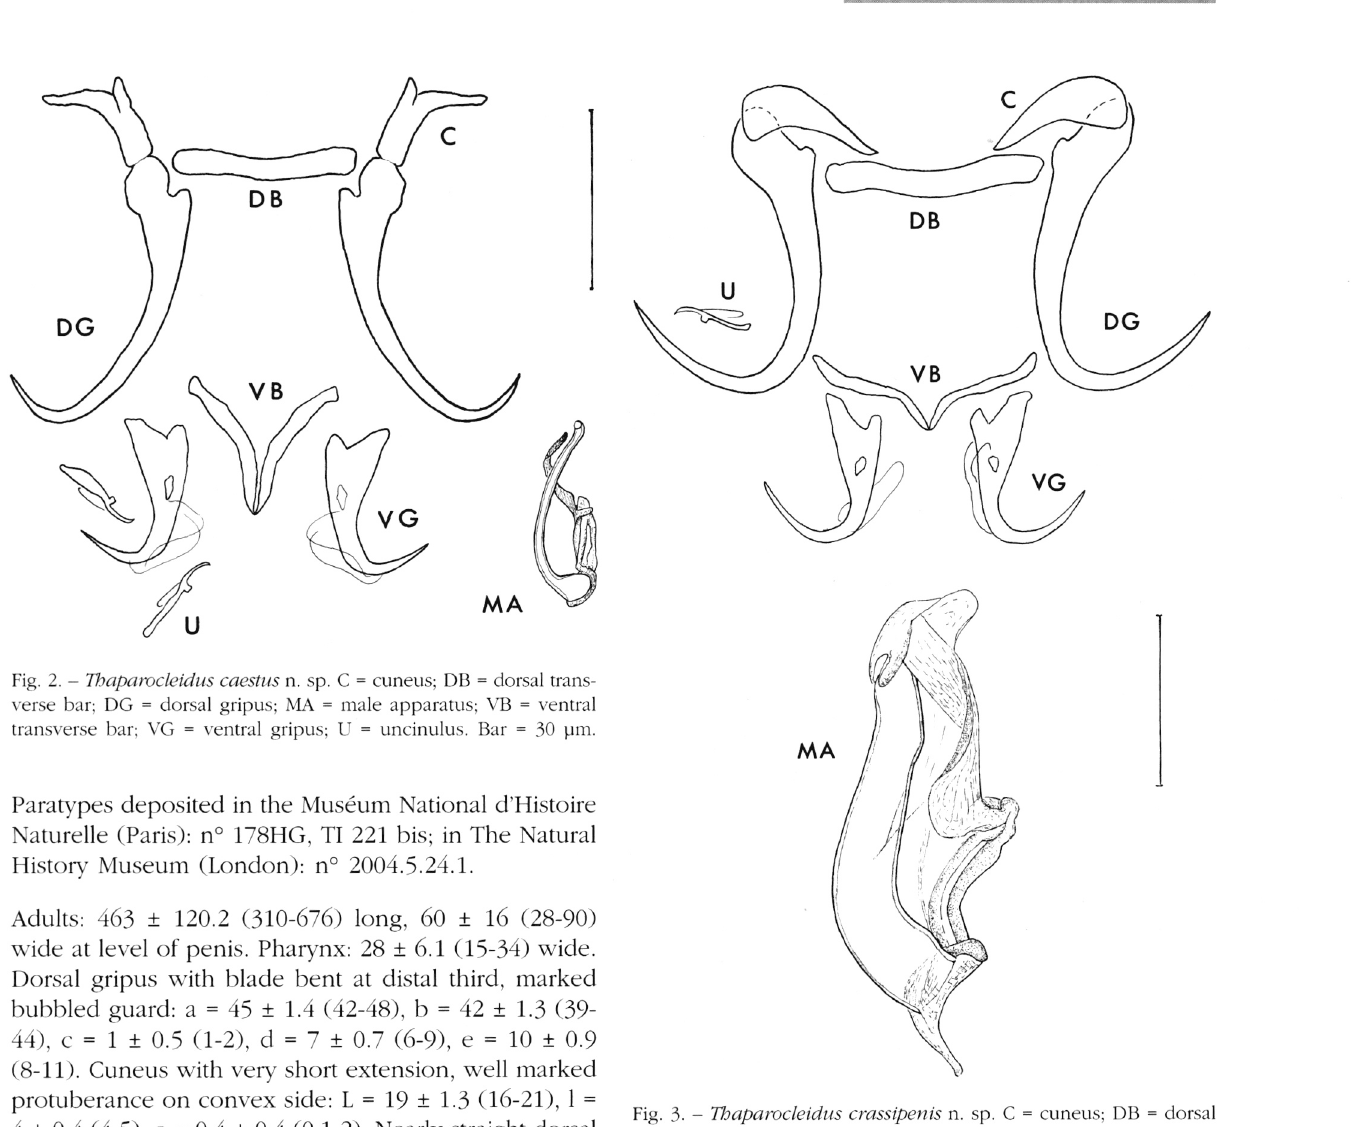
Fig. 3- - Thaparocleidus crassipenis n. sp. C = cuneus; DB = dorsal transverse bar; DG = dorsal gripus; MA = male apparatus; VB = ven­ tral transverse bar; VG = ventral gripus; U = uncinulus. Bar = 30